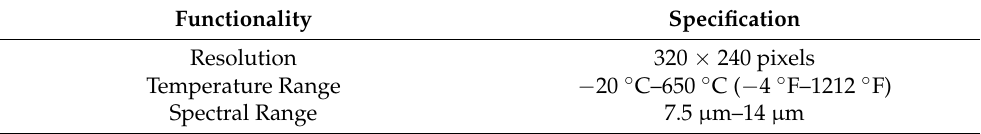
Table 2. Specification of Fluke Ti300+ with IR-fusion